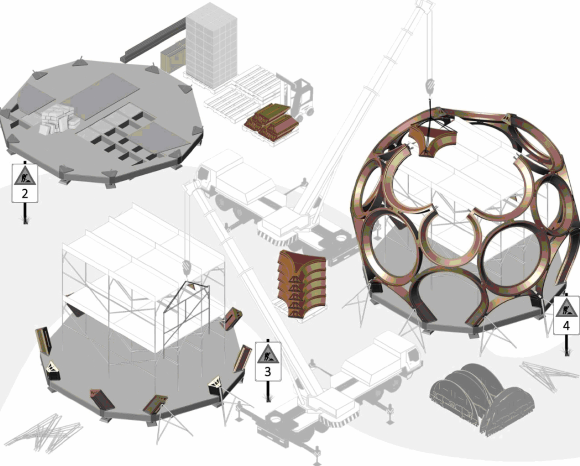
Figure 13: Assembling scheme and organization of the working site